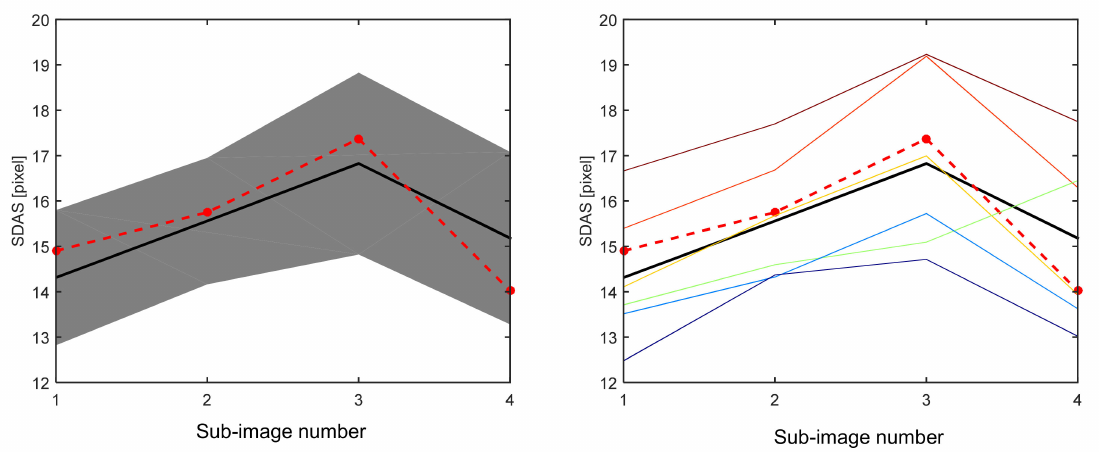
Figure 7. Comparison between the automated and manual SDAS measurements for the high eutectic cast; left: comparison of the automated (red, dashed) and manually measured (black, thick) SDAS values to the standard deviation (gray shaded region) of the distribution of manually measured SDAS values; right: comparison of the automated (red, dashed)–and manually measured (black, thick) SDAS values to the individual manual SDAS measurements (thin,